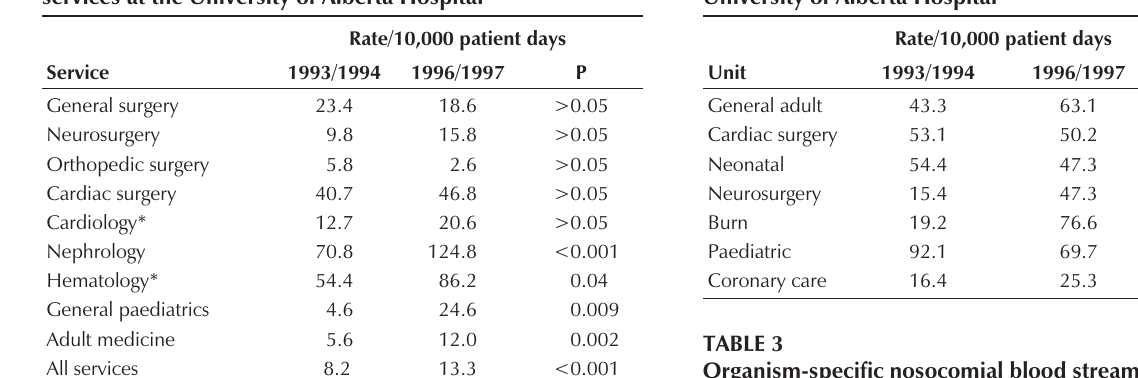
Intensive care unit nosocomial blood stream infections at the University of Alberta Hospital